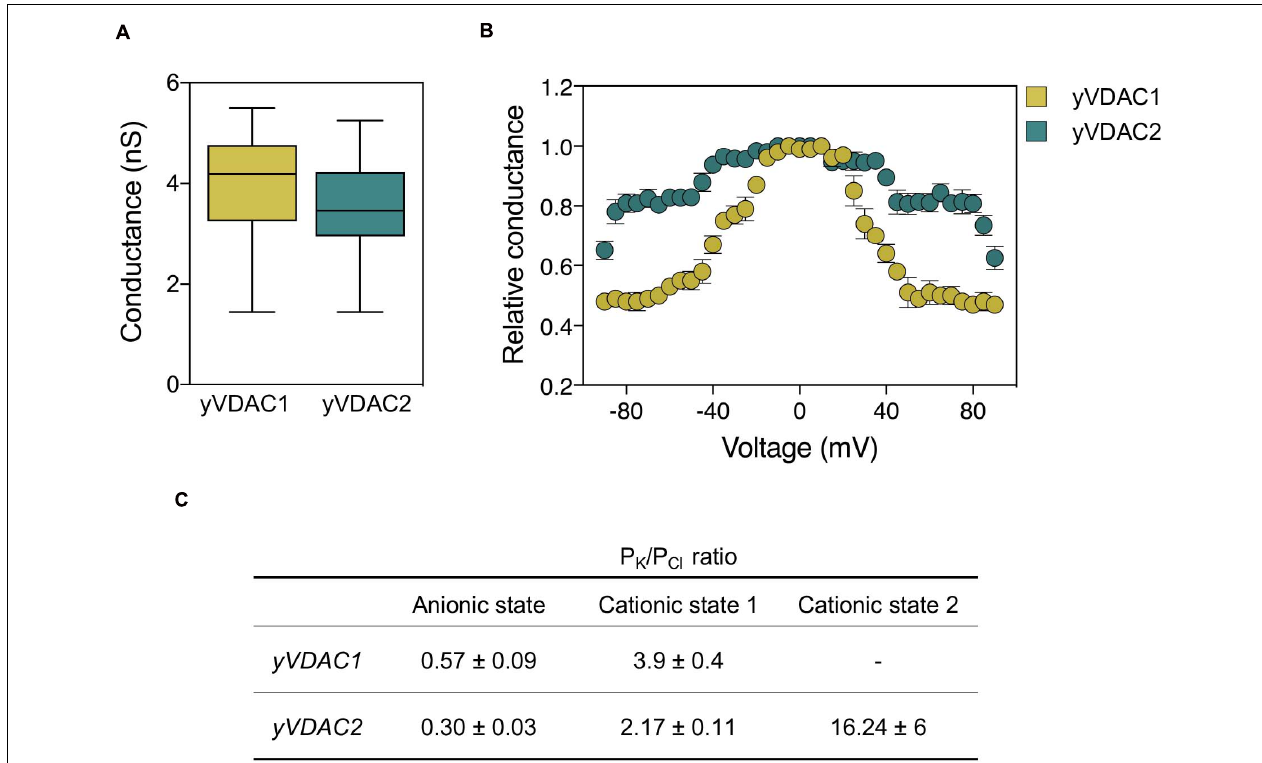
FIGURE 2 | Comparative analysis of the electrophysiological features of native yVDAC1 and yVDAC2 at the Planar Lipid Bilayer. (A) Analysis of conductance after yVDACs reconstitution into the artificial membrane. Experiments were performed with an applied constant voltage of +10 mV in 1 M KCl solution. (B) Analysis of the voltage-dependence of yVDACs isoforms. Experiments were performed by gradually increasing the voltage from 0 to ± 100 mV. Data are expressed as mean of the relative conductance ± SEM. The relative conductance was calculated as the G / G 0 , where G is the conductance at the given voltage while G 0 is the conductance values calculated at 0 mV applied. (C) Analysis of current-voltage performed in a 10-fold gradient 1/0.1 M cis/trans KCl in a voltage ramp with amplitude ± 60 mV. Values of reversal potential were used to estimate the permeability ratio of cations ( P K ) over anions ( P Cl ) by using the Goldman-Hodgkin-Katz equation in the three